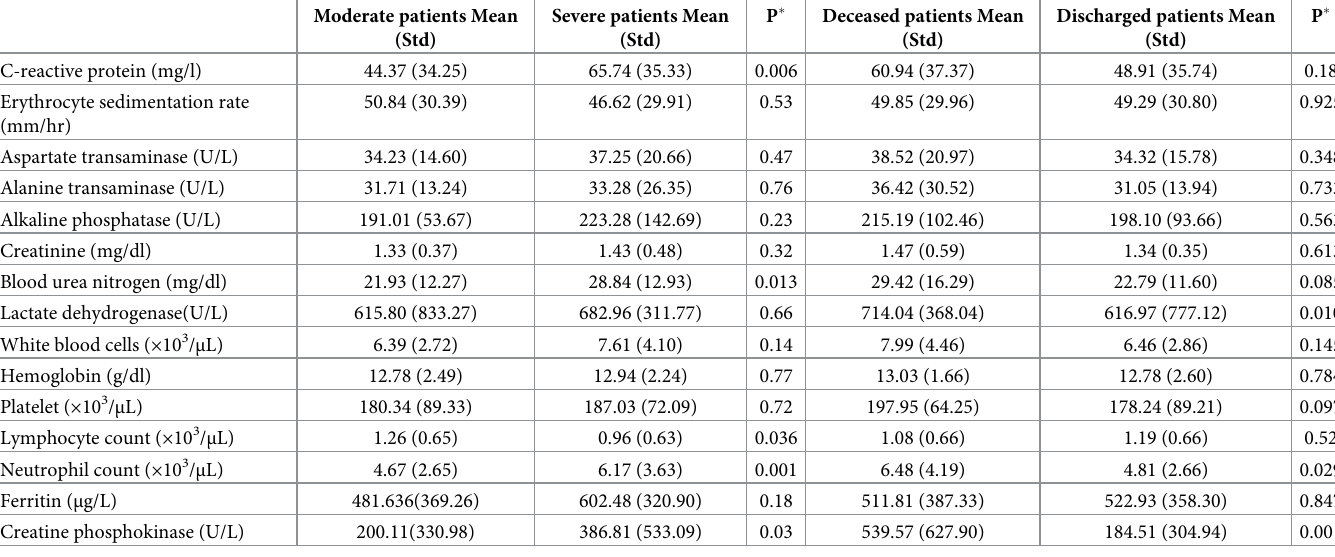
Table 2. Laboratory variables’ effect on disease severity and prognosis.